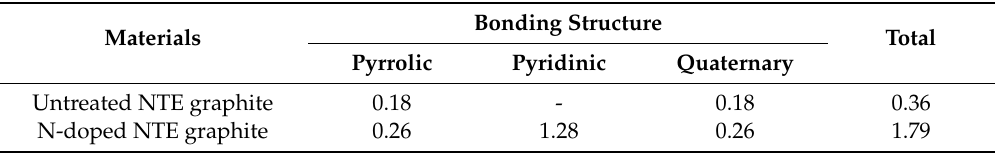
Table 3. X-ray photoelectron spectroscopy (XPS) atomic compositions of untreated NTE-graphite and N-doped NTE-graphite in atomic percent.